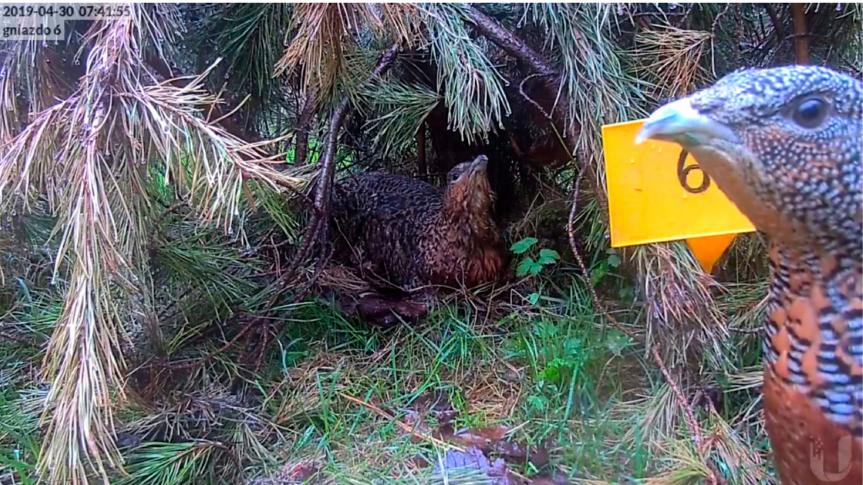
Figure 4. An example of female threatening attitude (TA) with a raised head, ru ffl ed feathers on the throat and making sounds caused by another female presence near the nest.